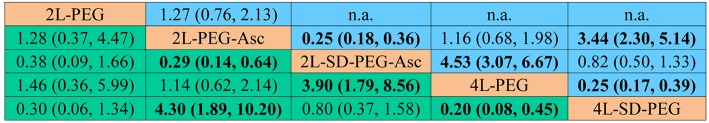
Summary for bowel preparation efficacy of different PEG-based bowel preparation regimes. The upper right area represented the effect sizes of direct comparisons and the bottom left shown the network comparisons. For direct comparison, it favors the row-defining treatment if odds ratio (OR) lower than 1, in contrast, for indirect comparison, the result favors the column-defining treatment if OR lower than 1. For numerical data, each number in each cell represented the effect size of the treatment in upper left area minus the treatment in bottom right area. Bold font represented statistical significance. PEG, polyethylene glycol; Asc, ascorbic acid; SD, split-dose; n.a., not available.